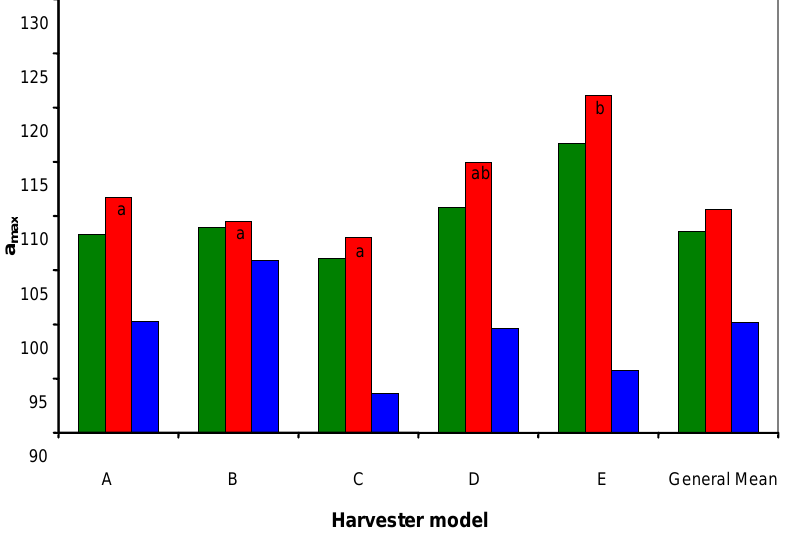
Figure 6. Impact acceleration (a ) for each harvester and each zone:  harvester mean max value;  zone 1;  zone 2. Zone 1: combine elements from cutting device to second belt. Zone 2: combine elements from second belt to loading onto the trailer. Different letters in each column are significantly different (p <